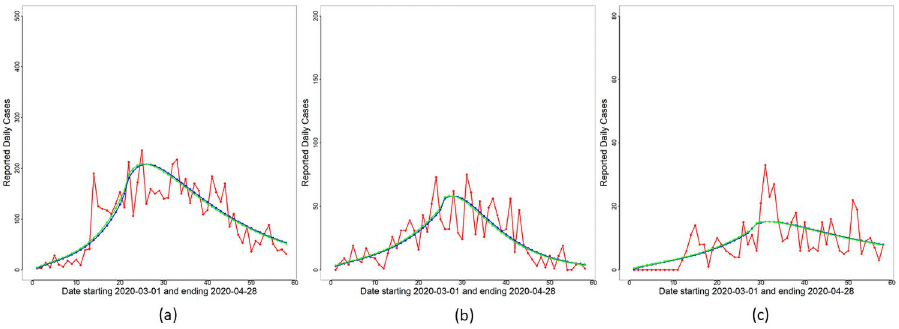
Fig 3. Constant rate submodel—Daily cases. Reported daily cases (red line), and overlay plots of Δ R o ( t ) (blue line) for the constant rate submodel for (a) Malaysia, (b) Selangor and (c) Sarawak. and F ( t ) (green line) based on ^ Y MAP